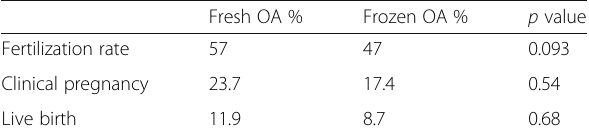
Table 2 Comparison of outcomes between fresh and frozen- thawed obstructive azoospermia group Fresh OA % Frozen OA % p value Fertilization